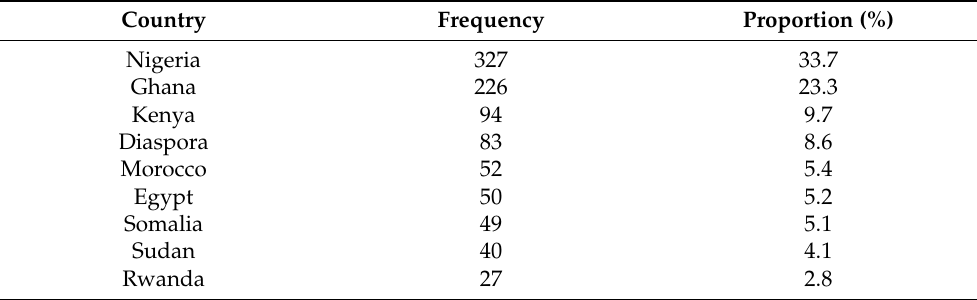
Table 1. Distribution in some African countries based on the number of willing participants. Country